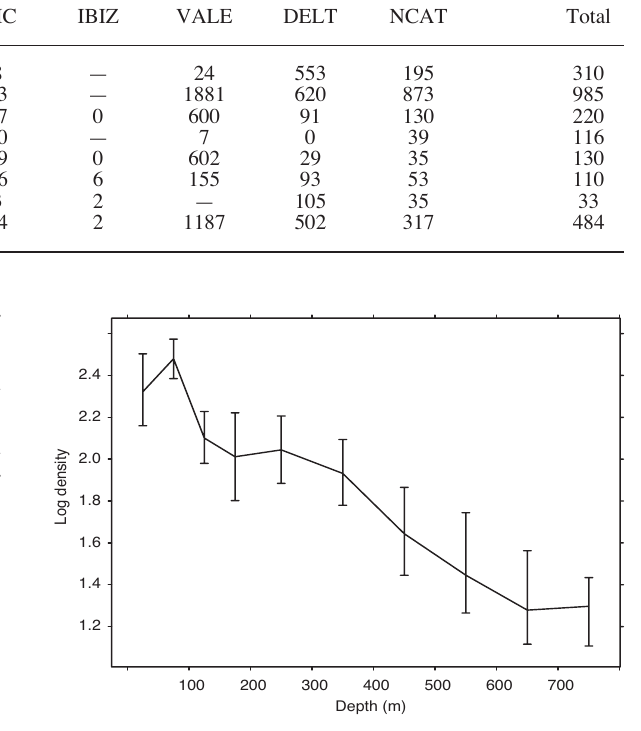
F IG . 6. – The variation in Liocarcinus depurator median density (log (number · km -2 + 1)) (± CI ) with depth along the Iberian 10 95% Peninsula Mediterranean coast from 1994 to